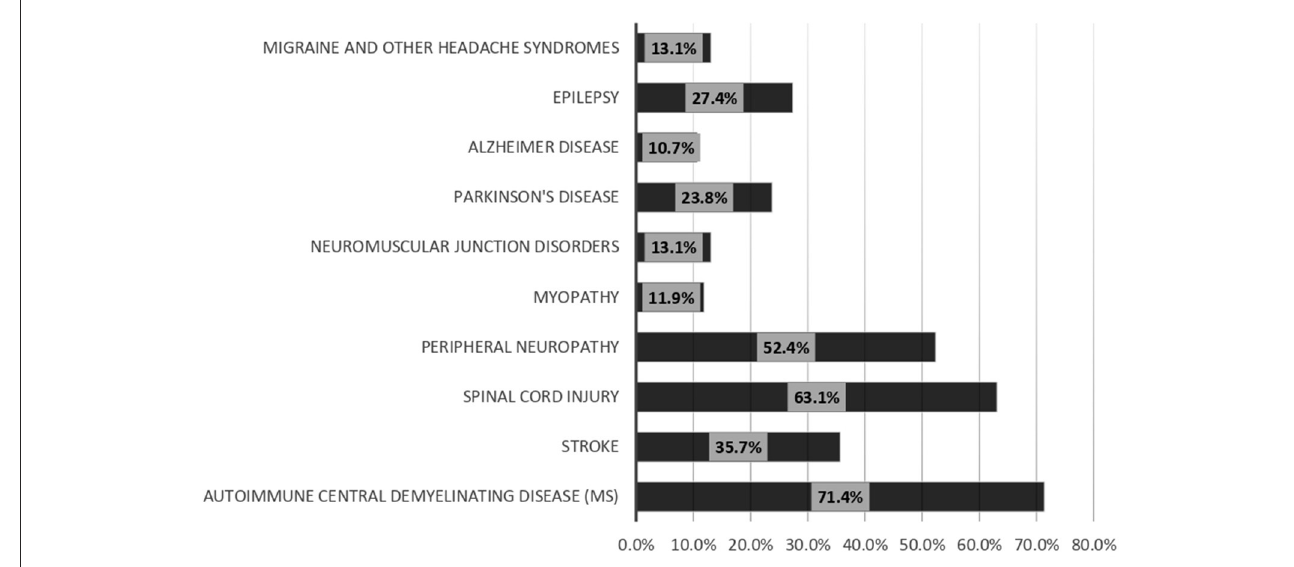
FIGURE6 What type of disease you always discussing the sexual problem with